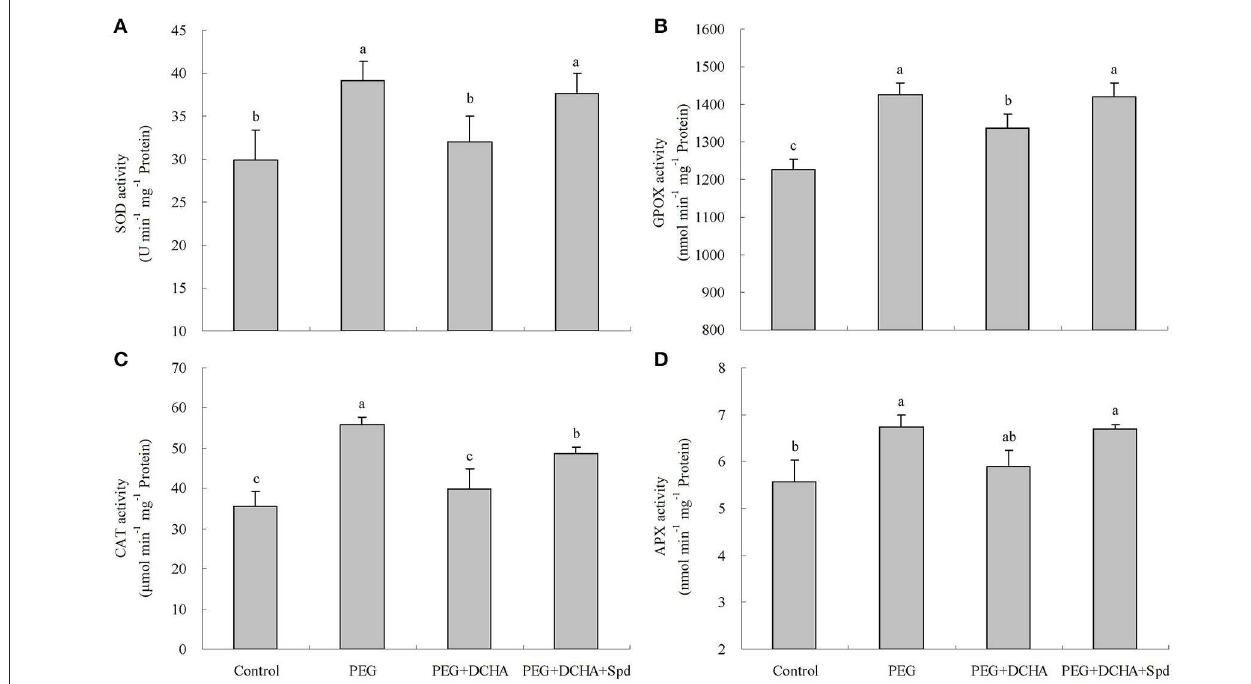
FIGURE 8 | Antioxidant activities as affected by polyamines (PA) under PEG-induced water stress. SOD (A) , GPOX (B) , CAT (C) , and APX (D) The detached leaves of white clover were pre-treated with distilled water for 1h to eliminate wound stress and then treated for 8h as follows: 1, distilled water (control); 2, 15% PEG; 3, 15% PEG + 100 µ M dicyclohexylamine (DCHA); 4, 15% PEG + 100 µ M DCHA + 20 µ M Spd. Means of six independent samples are presented. Bars represent standard errors. The same letter indicates no significant difference (LSD) at P < 0.05.